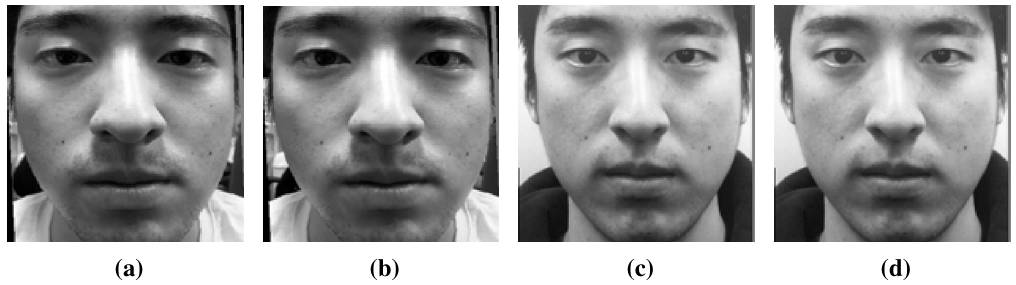
Figure 6. Normalized webcam images (real face images focused on ( a ) the nose and ( b ) the ear; and fake face images focused on ( c ) the nose and ( d ) the ear).